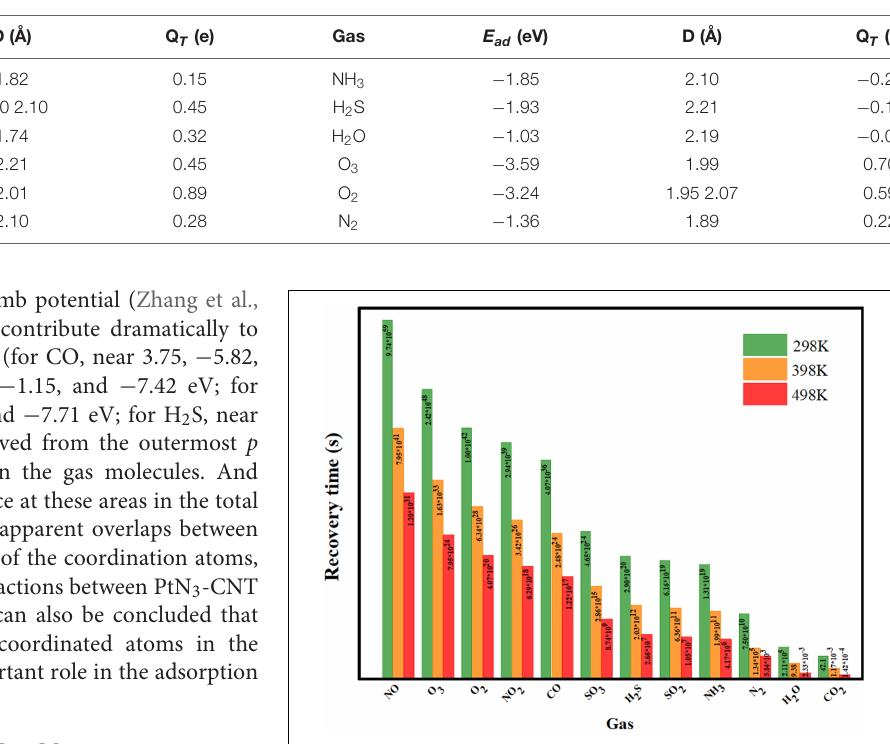
the recovery time for the desorption of all the gas molecules from the PtN 3 -CNT surface at 298, 398, 498 K were